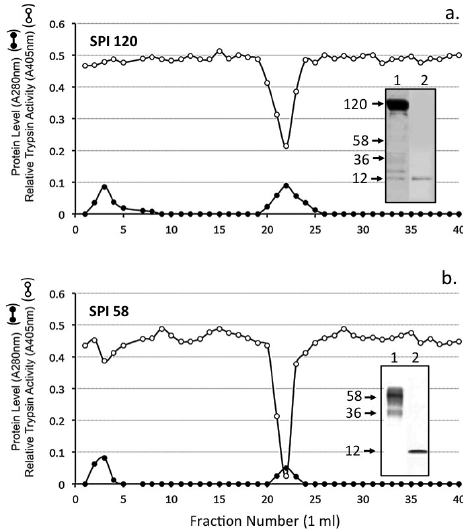
Figure 4. Chymotrypsin affinity chromatography of the SPI 120 ( a ) and SPI 58 ( b ) SPI pools 1 and 2 from Figure 3a. The insets depict biotinylated trypsin (bT) affinity blots, which identify active SPIs in the sample prior to (1) and after (2) chymotrypsin affinity chromatography. Concanavalin A lectin affinity chromatography of the SPI58 sample from Sephadex G100 chromatography (SPI Pool 2, Figure 3a) resulted in the isolation of a bound SPI pool containing a closely spaced SPI doublet (45–58 kDa) and minor 36 kDa species (Figure 5).